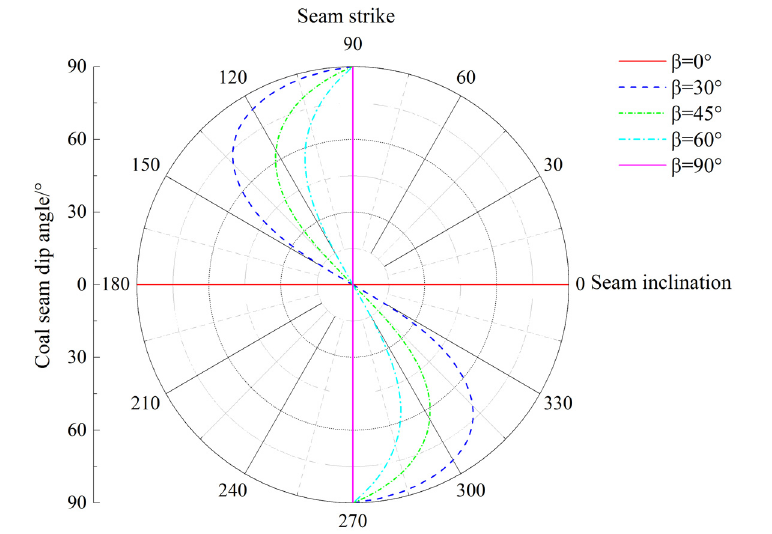
Figure 12. Relationship between the initial cracking location and coal seam dip angle.